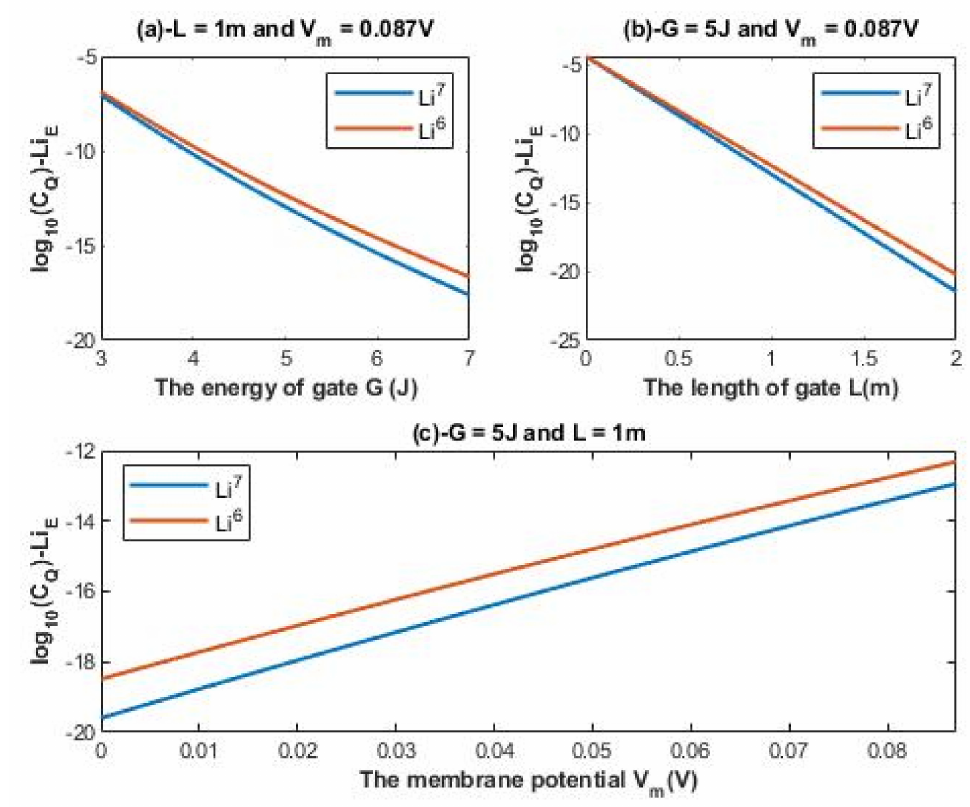
Figure 4. ( a ): The figure represents the relationship between the common logarithm of quantum ( C ) − Li conductance of single channel for the extracellular lithium isotopes log E and the energy Q 10 of gate G by setting L = 1 m and V m = 0.087 V and across the range of G from 3 J to 7 J. ( b ): The figure represents the relationship between the common logarithm of quantum conductance of single ( C ) − Li channel for the extracellular lithium isotopes log E and the length of the gate L by setting Q 10 G = 5 J and V m = 0.087 V and across the range of L from 0 m to 2 m. ( c ): The figure represents the relationship between the common logarithm of quantum conductance of single channel for the ( C ) − Li = 5 J and extracellular lithium isotopes log E and the membrane potential by setting G Q 10 L = 1 m and across the range of membrane potential from 0 V to 0.087